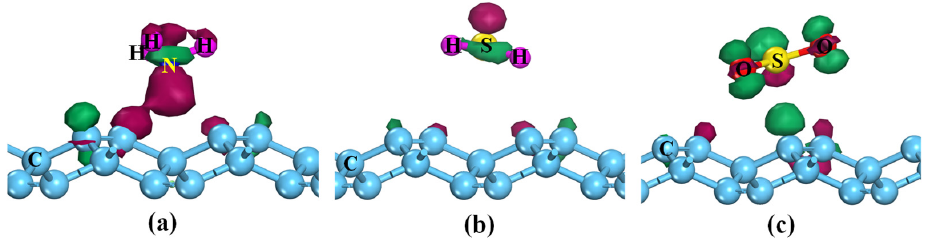
Figure 4. Charge density difference of different adsorption systems ( a ) NH 3 @PG, ( b ) H 2 S@PG, and ( c ) SO 2 @PG. The green (red) region is electron accumulation (depletion), and the isosurface is ±0.01 e/Å − 3 .